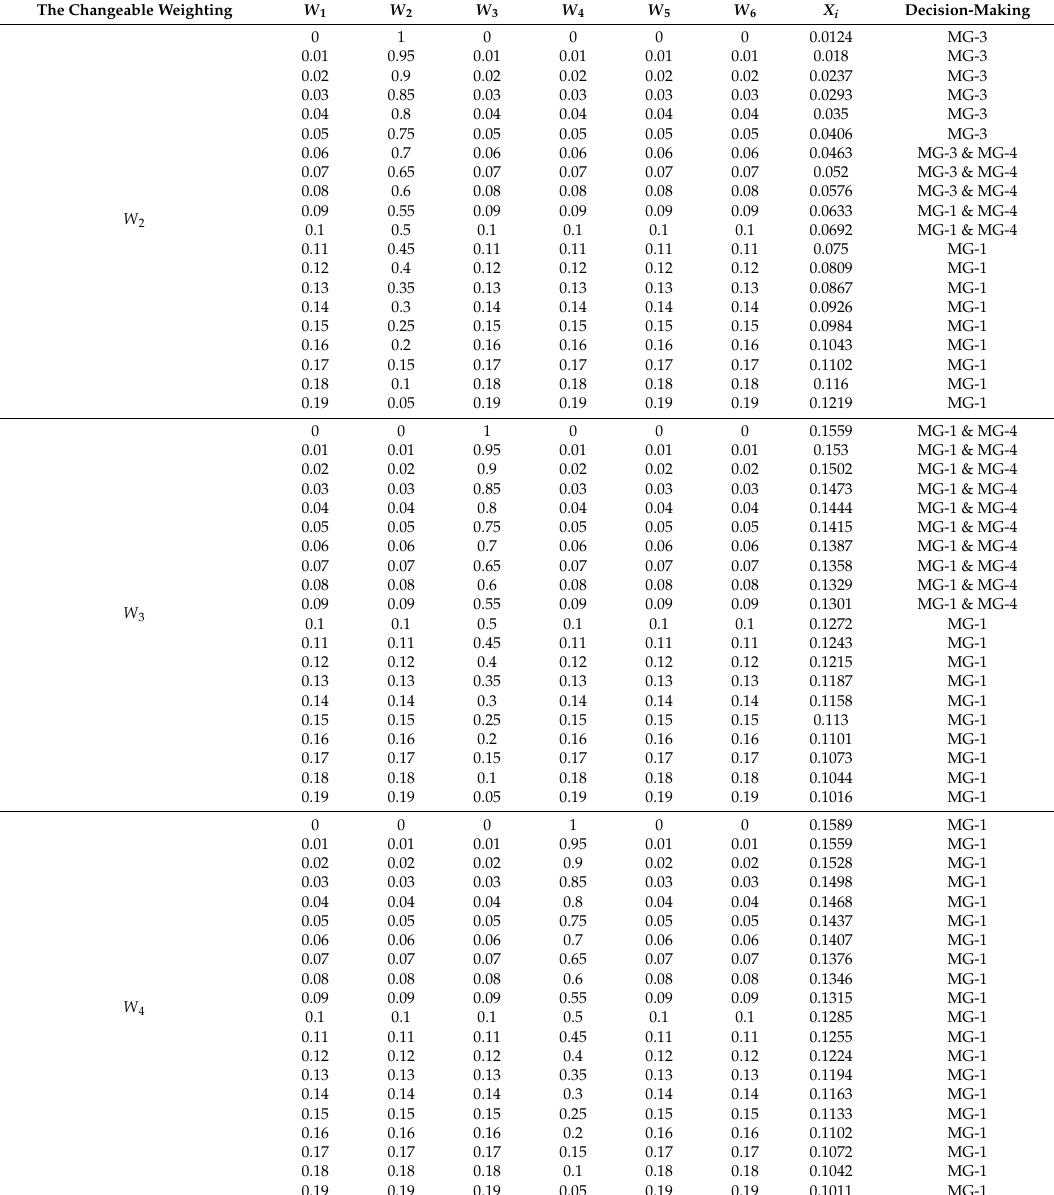
Table A2. Biased weighted index of frequency deviation, reliability and power loss in transmission line indices. The Changeable